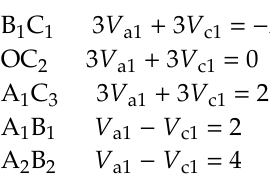
Figure 6. Diagram of region partition in Sector I.